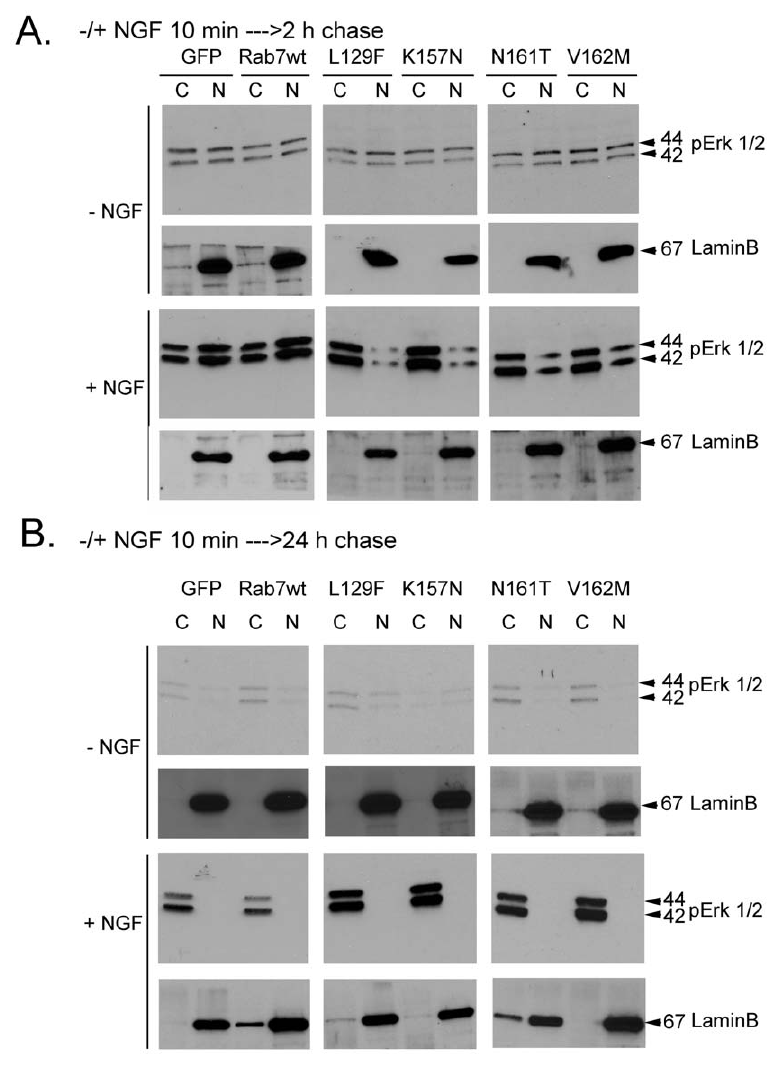
Figure 5. Cells Expressing Rab7 CMT2B Mutants Exhibit Altered Cytoplasmic and Nuclear Partitioning of Activated Erk1/2. Transiently transfected PC12 cells expressing GFP, GFP-Rab7wt, GFP-Rab7L129F, GFP-Rab7K157N, GFP-Rab7N161T, GFP-Rab7 V162M were briefly stimulated with NGF (200 ng/ml) followed by surface stripping of ligand and reincubation in 0.1% BSA-DMEM for (A) 2 h and (B) 24 h. Subsequently, cells were lysed and subjected to subcellular fractionation and immunoblotted with antibodies directed against phosphorylated Erk1/2. The purity of fractions was confirmed by probing for the nuclear marker lamin B.